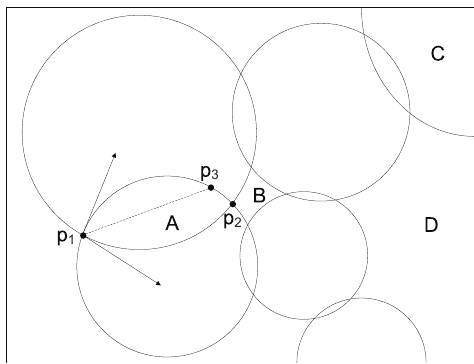
Figure 3. Intersected circles and divisions.